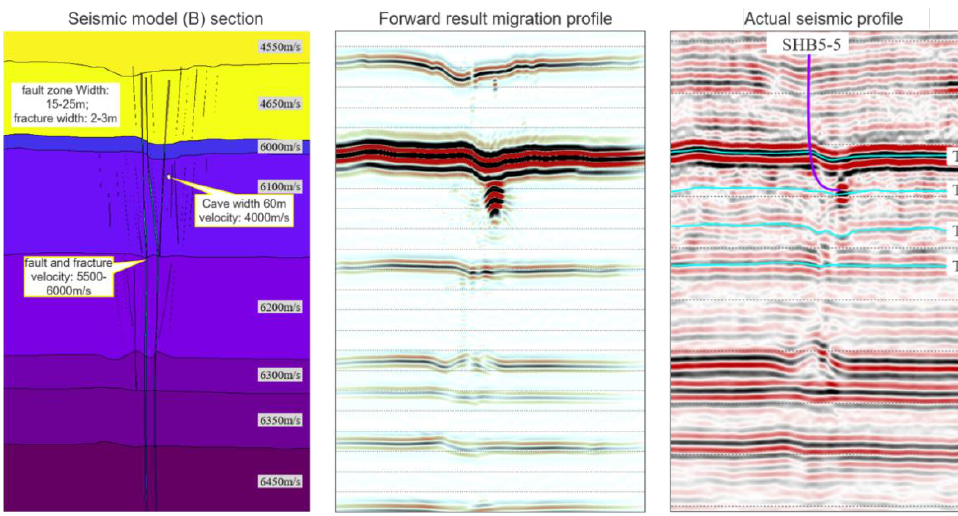
Figure 12. A comparison between migration results of forward model B and seismic profile of actual drilling.